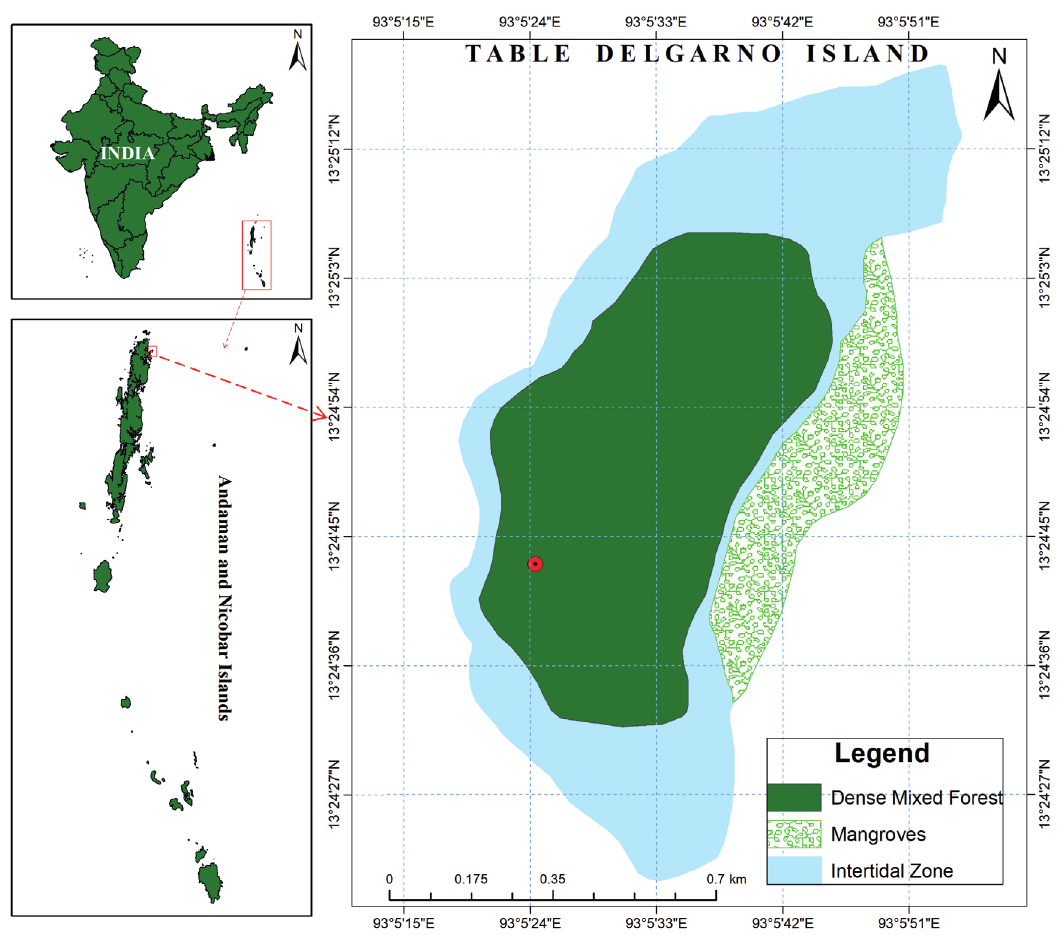
Fig. 1. Collection locality of the new taxa marked with red